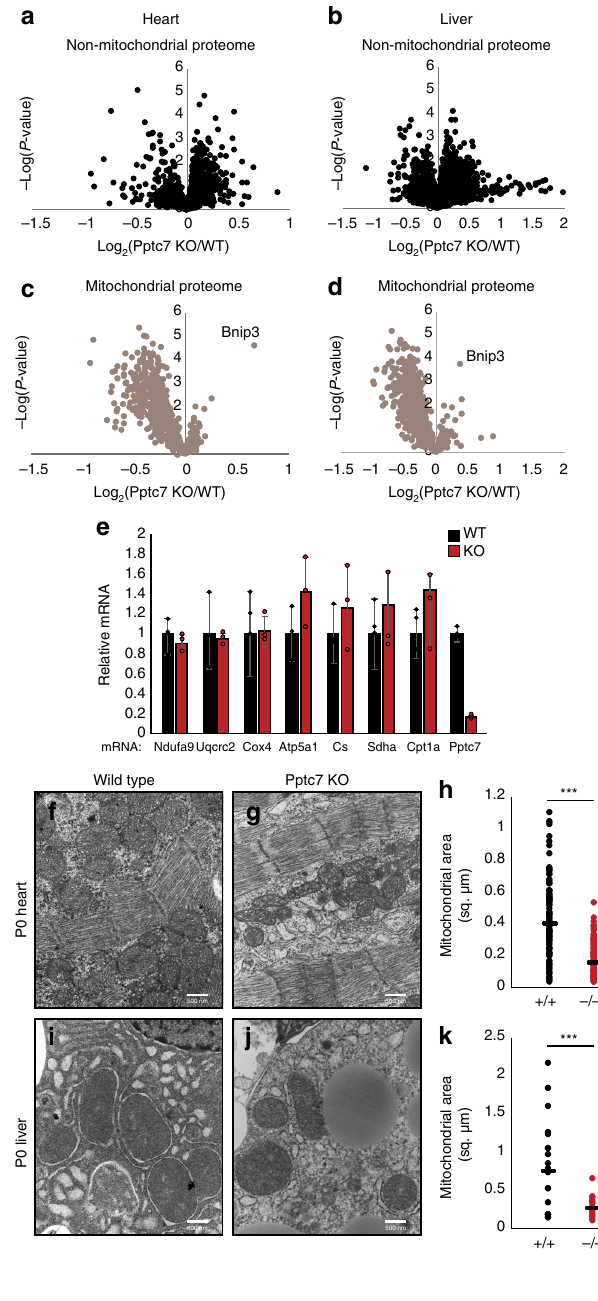
Fig. 3 Loss of Pptc7 selectively decreases mitochondrial content. a – d Volcano plots of non-mitochondrial ( a , b ) proteins and mitochondrial ( c , d ) proteins in both heart ( a , c ) and liver ( b , d ); n = 5 tissues per genotype. One of the only signi fi cantly increased mitochondrial proteins is Bnip3, a protein induced during organellar stress. e qPCR of select nuclear-encoded mitochondrial targets from WT (black, n = 4) or KO (red, n = 3) heart tissue shows no signi fi cant decrease ( p > 0.05) between genotypes, except for Pptc7 . Error bars represent standard deviation; signi fi cance calculated with a two-tailed Student ’ s t -test. f – h Transmission electron microscopy (TEM) was used to image heart tissue from WT ( f ) and Pptc7 KO ( g ) mice. Mitochondrial area was quanti fi ed in ImageJ with size extrapolated from the scale bar (500 nm). KO heart mitochondria ( n = 110) are signi fi cantly smaller than those in WT tissues ( n = 105) ( h ). i – k TEM images of liver tissue from WT ( i ) and Pptc7 KO ( j ) and analyses as described for heart tissue; KO liver mitochondria ( n = 17) are signi fi cantly smaller than WT mitochondria ( n = 20) ( k ). For h , k , each dot represents the area of a single quanti fi ed mitochondrion in WT (black) or KO (red) tissues; the line represents the median area in each condition. For statistical analysis, signi fi cance was calculated using a two-tailed Student ’ s t -test; *** = p < 0.001. Source data for panels a – d are provided as Supplementary Datasets 1 and